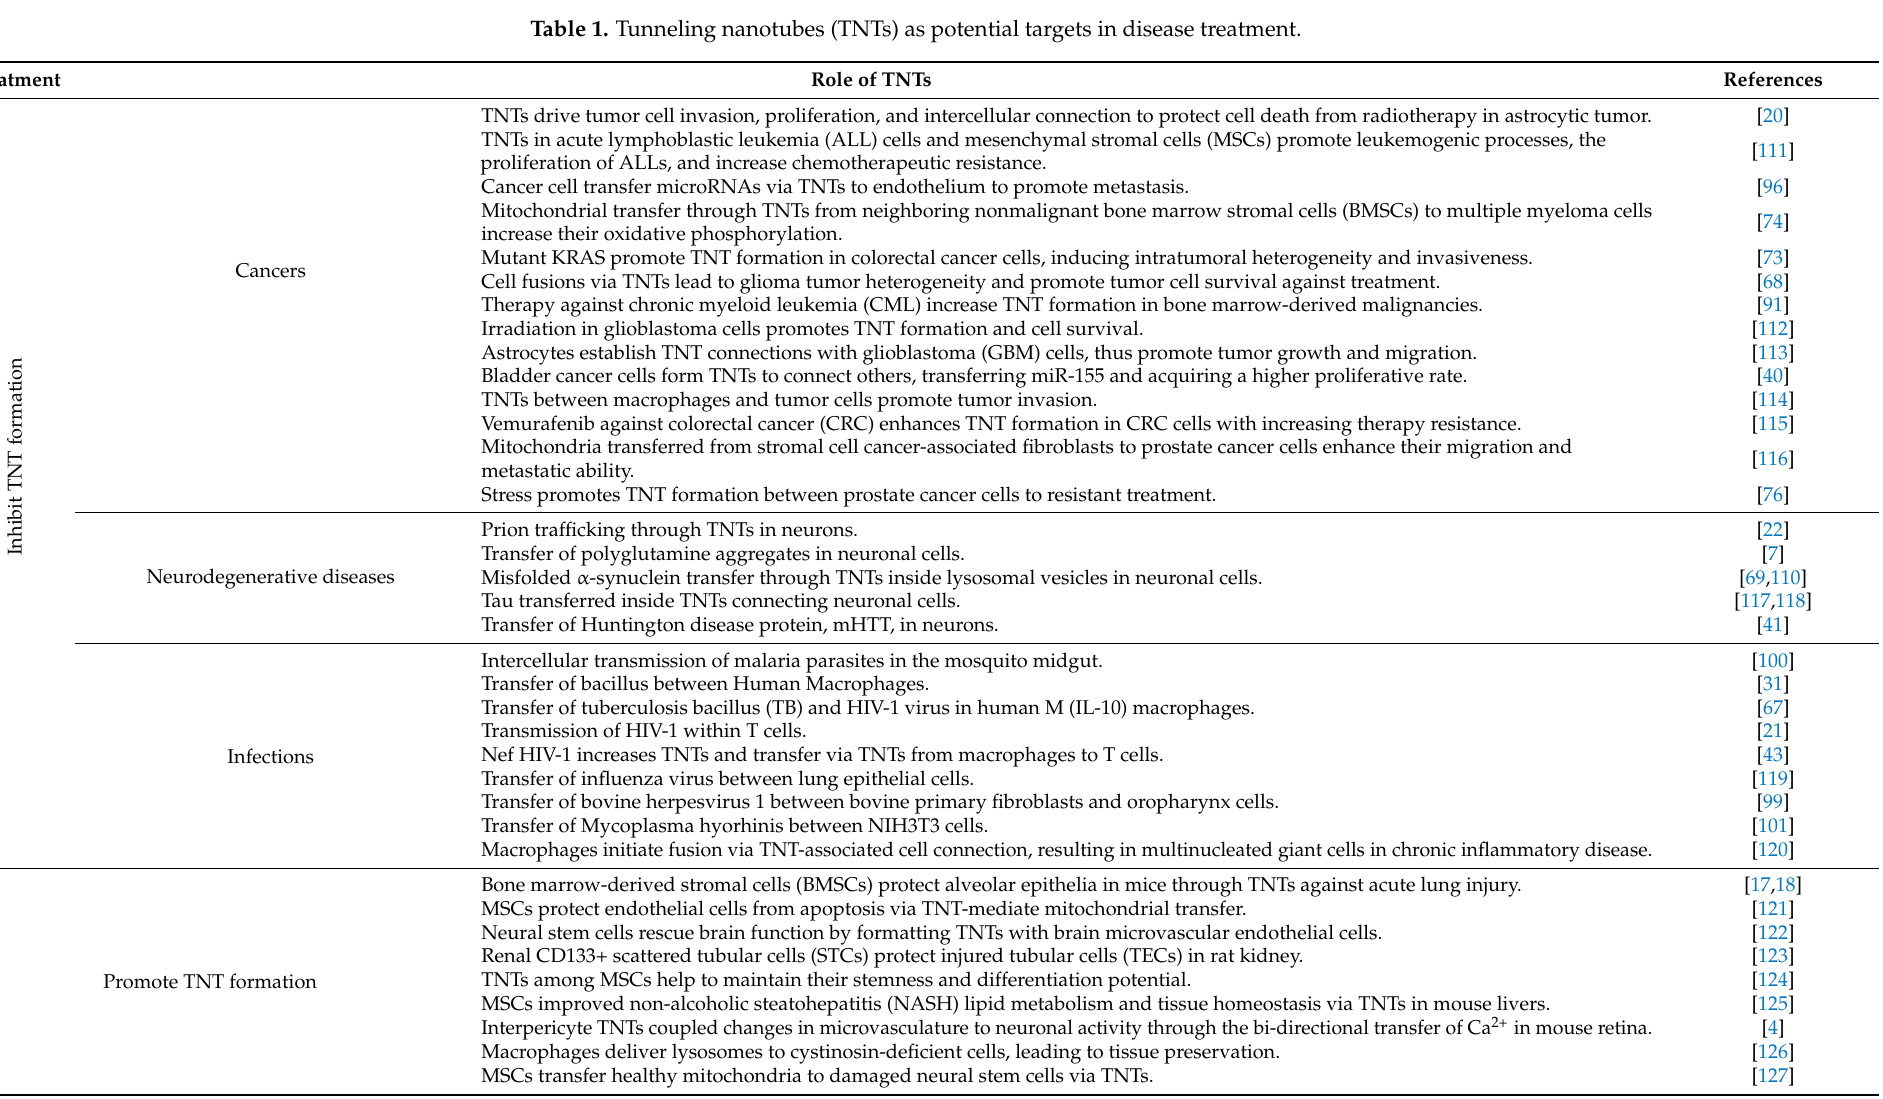
Table 1. Tunneling nanotubes (TNTs) as potential targets in disease